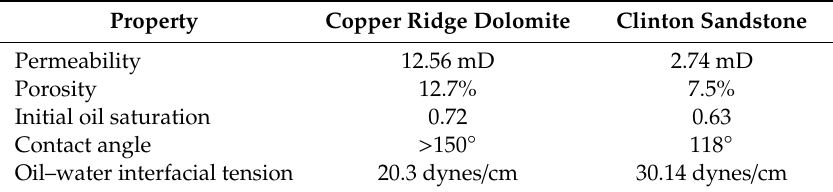
Table 2. Core characterization